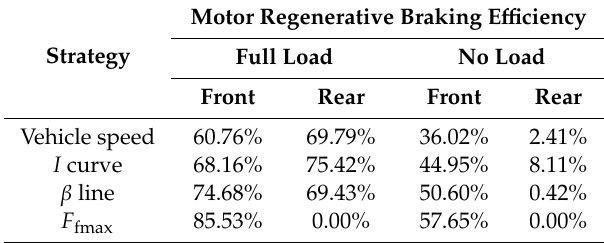
Table 4. Front and rear motor braking efficiency.